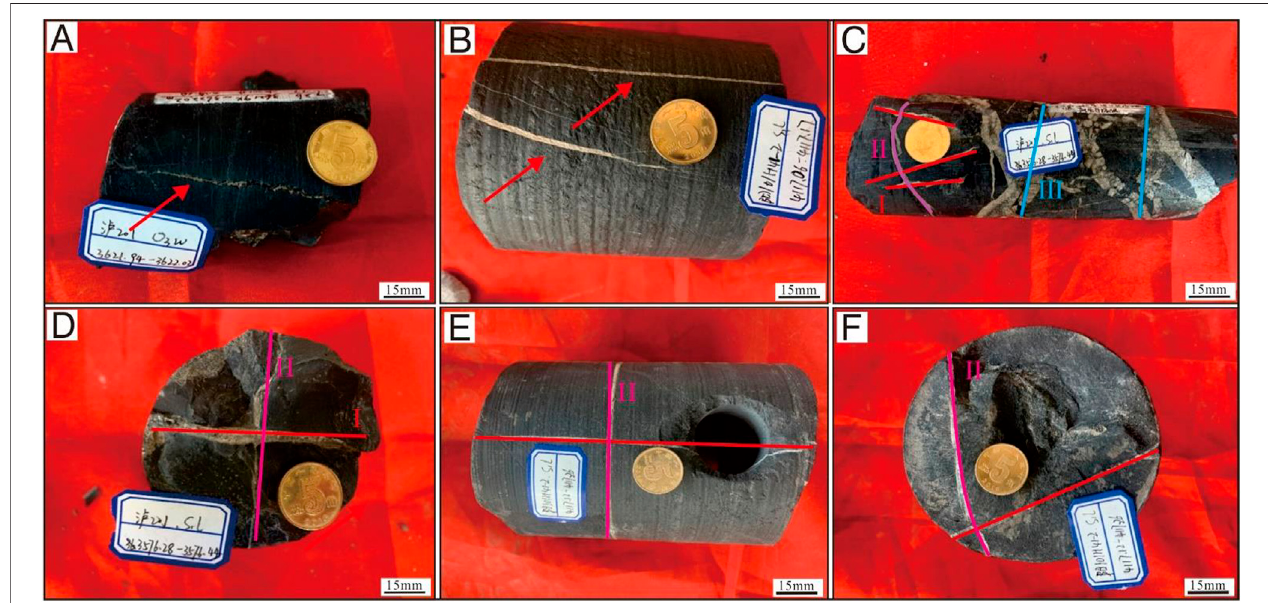
FIGURE 4 | Intersection relationship of typical core fractures of Longmaxi formation in Luzhou